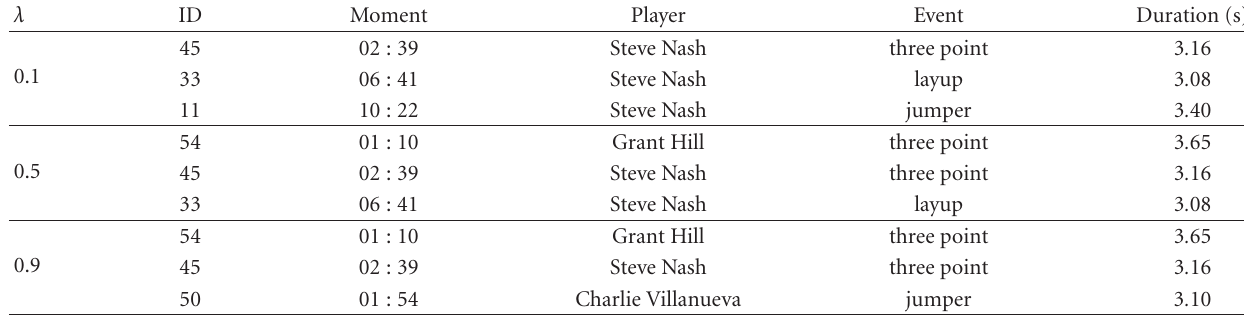
Table 6: Customized video segments under di ff erent fusion parameters.